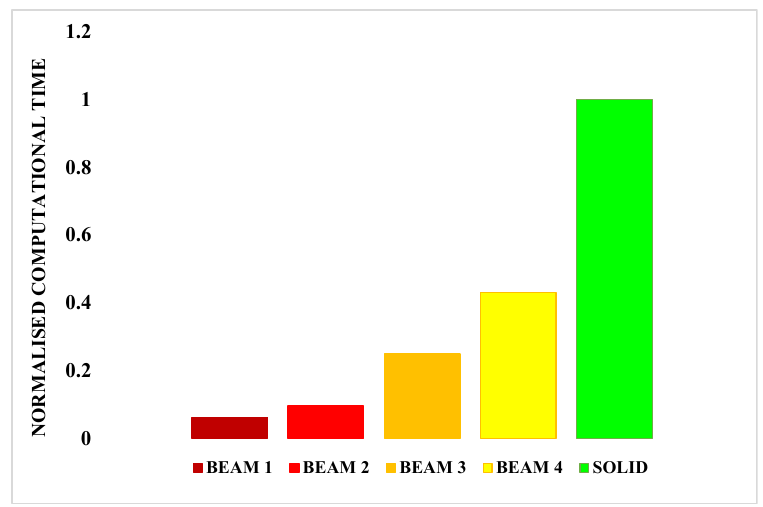
Figure 11. Mesh sensitivity analysis: normalised computational times.